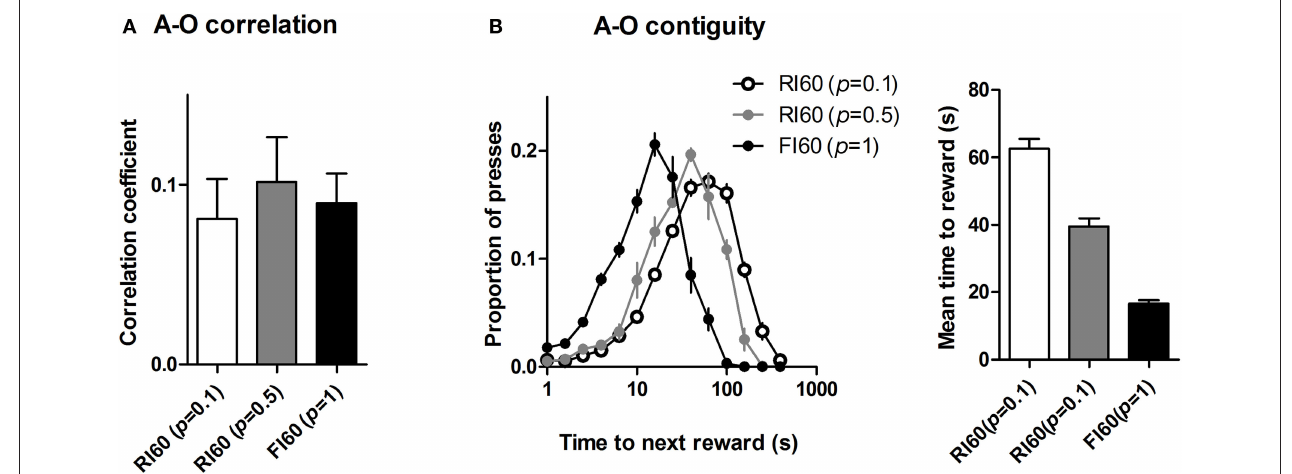
e.g. actions are closer to subsequent rewards under FI 60 schedule with high certainty. The left panel shows distribution of time until next reward for each lever press. The right panel shows mean values for the time to reward